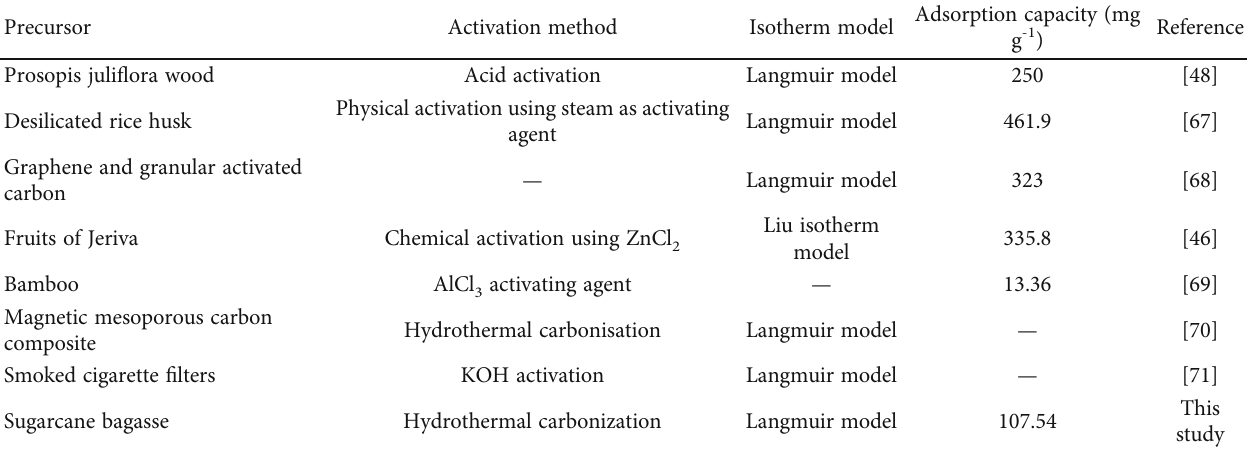
Table 3: Comparison on the performance of ACS-K with other adsorbents in removing cipro fl